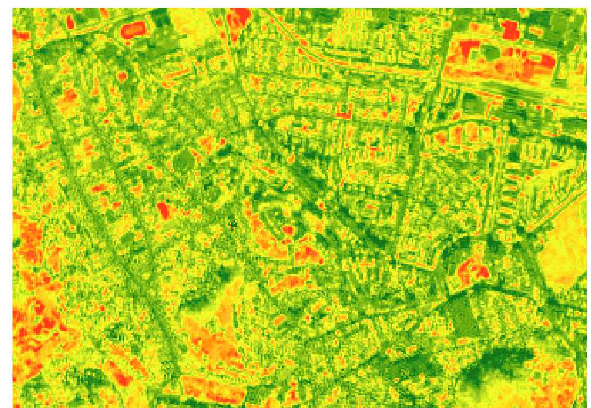
Figure 6 . NDVI for year